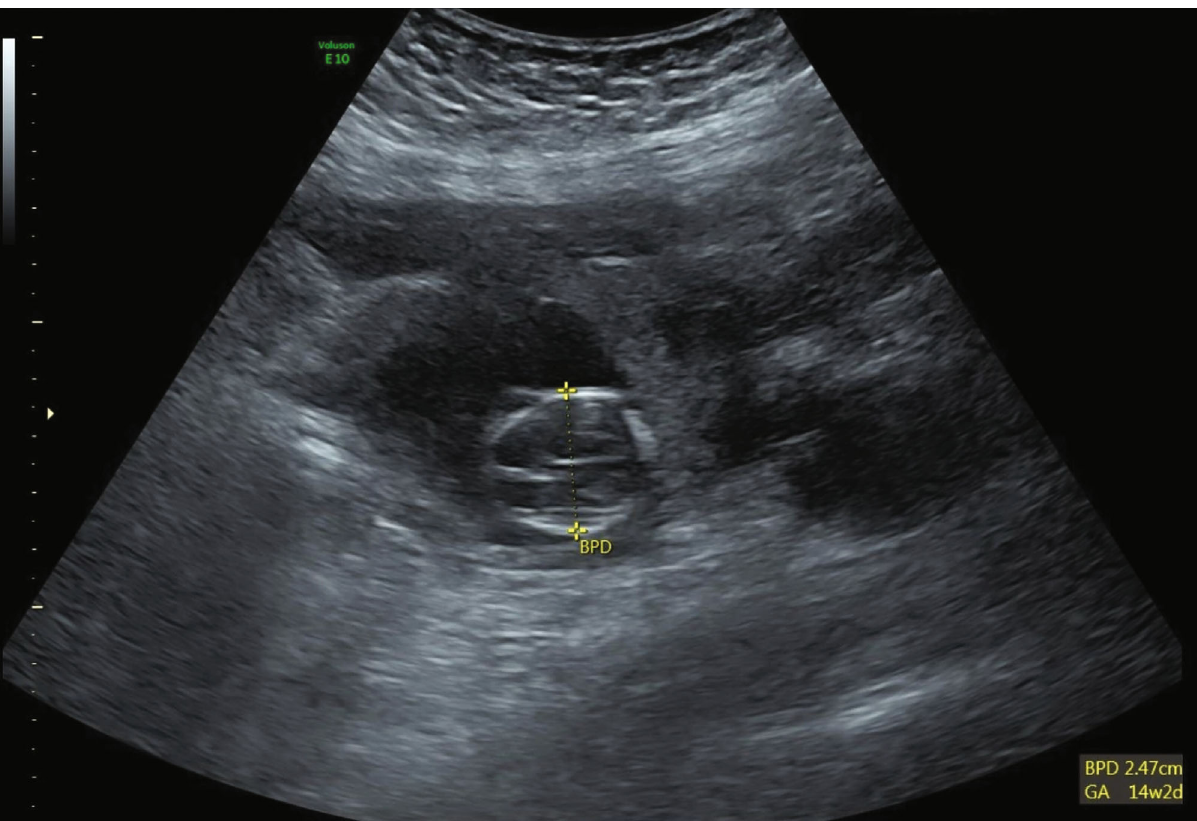
Figure 3: Ultrasound shows the biparietal diameter (BPD) measuring 2.47cm which equals 14 weeks and 2